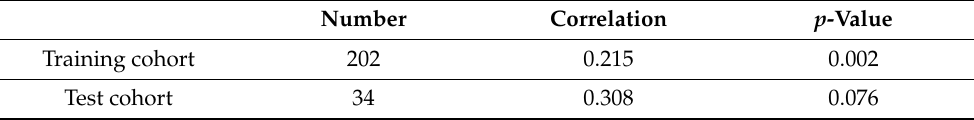
Table A3. Comparison of classification performance using statistical analysis. AUC value of tradi- tional deep learning (ResNet) was 0.618, which was significantly inferior to that of the proposed model ( p =